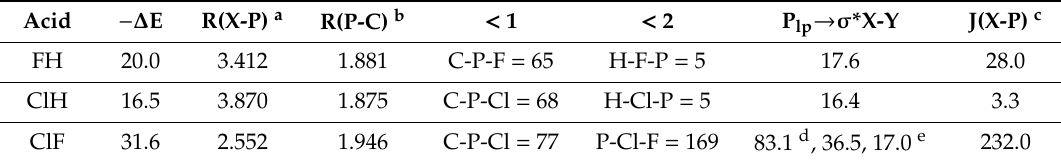
Table 1. Binding energies ( − ∆ E, kJ mol − 1 ), distances (R, Å), selected angles ( < , o ), charge-transfer energies (CT, kJ mol − 1 ), and spin–spin coupling constants across intermolecular bonds [J(X-P), Hz] for complexes XY:P(CH) 3 isomers A